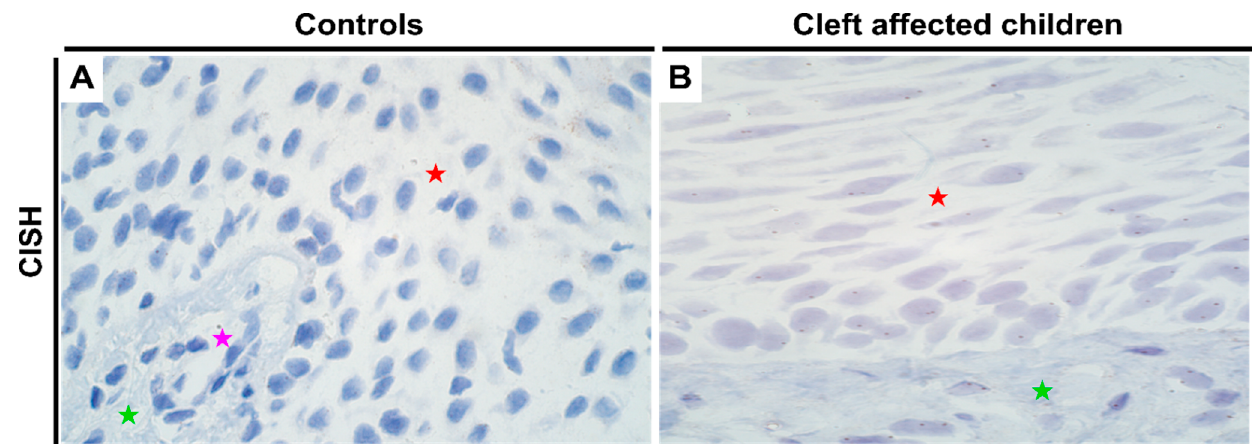
Figure 4. Expression of NF- κ B protein complex visualized using IHC in controls and cleft patients. Protein expression of NF- κ B was visualized using immunohistochemistry (IHC) in ( A ) controls and ( B ) cleft affected children. ( A ) No positively stained (0) structures are visible in tissue obtained from controls; ( B ) Moderate number (++) of positively stained inflam- matory cells are seen in the cleft tissue obtained from a three-month-old boy. Original magnification, 200×. Red star indi- cates epithelium while green star indicates connective tissue.